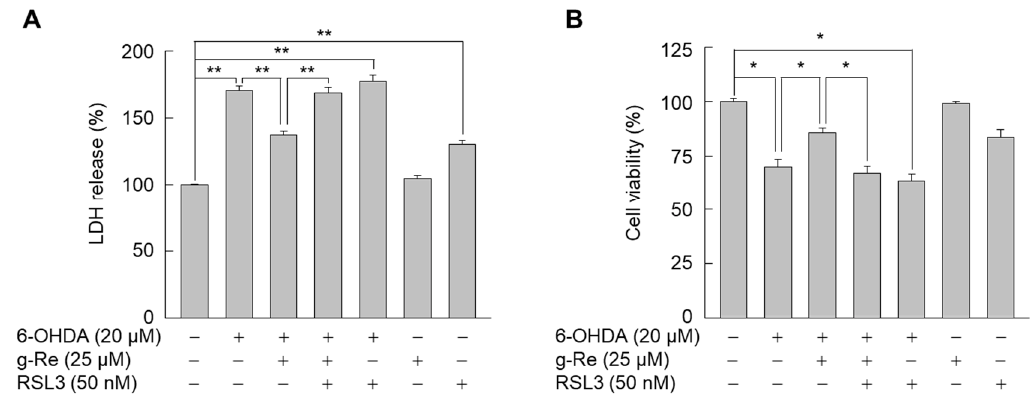
Figure 8. Effects of GPX4 inhibition on ginsenoside Re (g-Re)-mediated suppression of 6-OHDA-induced cellular damage. ( A , B ) SH-SY5Y cells pretreated with or without (1S,3R)-RSL3 (RSL3) were incubated in the presence or absence of g-Re for 9 h and then treated with or without 6-OHDA for 24 h. Cells were subjected to the LDH release assay ( A ) and MTT assay ( B ). Data are presented as mean ± SE (n = 3). * p < 0.05, ** p < 0.01.